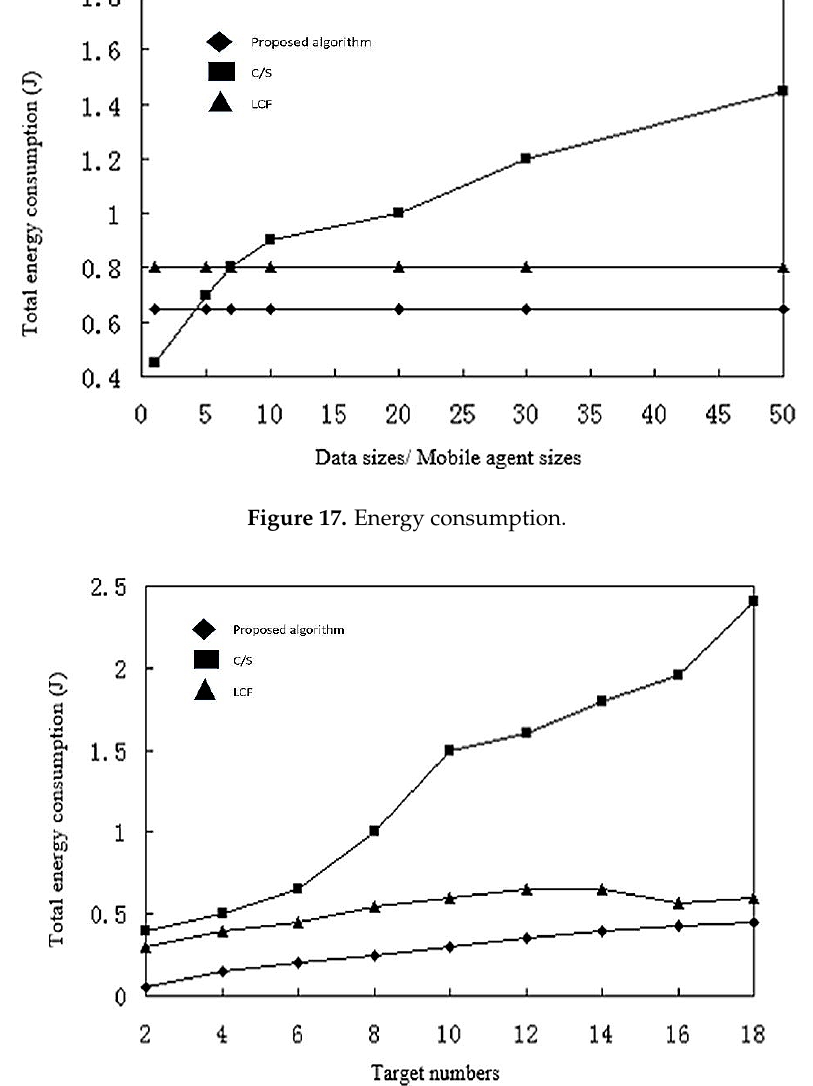
Figure 18. Energy consumption for different target numbers.